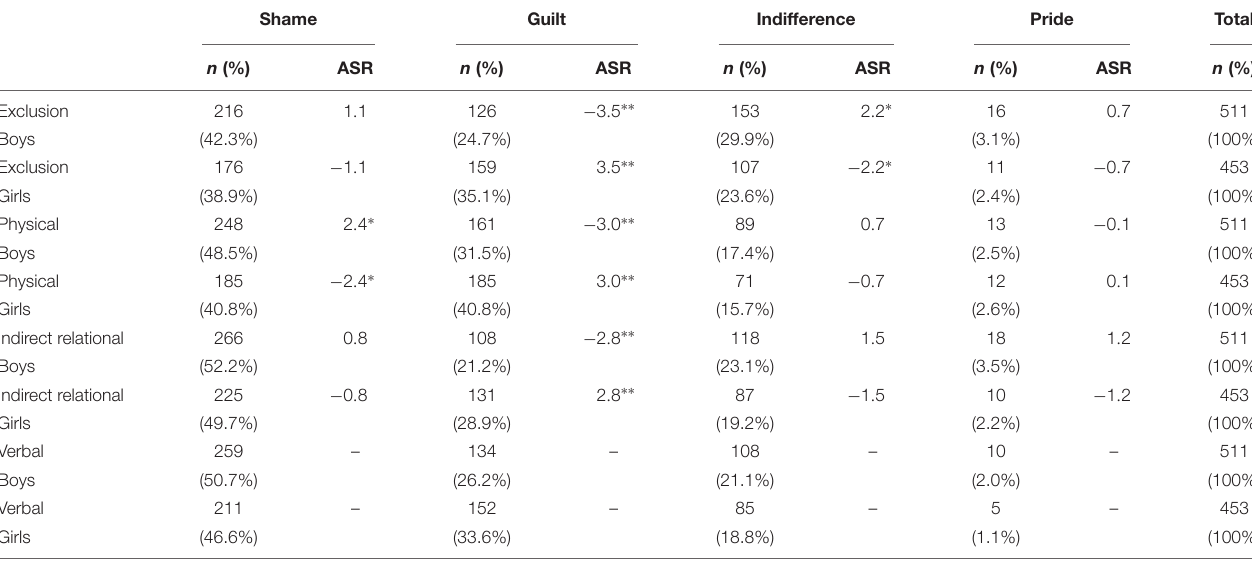
TABLE 4 | Percentages of moral attribution to others and